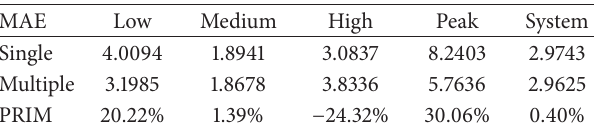
Figure 4: Forecasted electricity MCP in June 2009 using both single and two-stage multiple SVM. Table 2: Performance evaluation results of MAE between the single and the two-stage multiple SVM in June 2009.